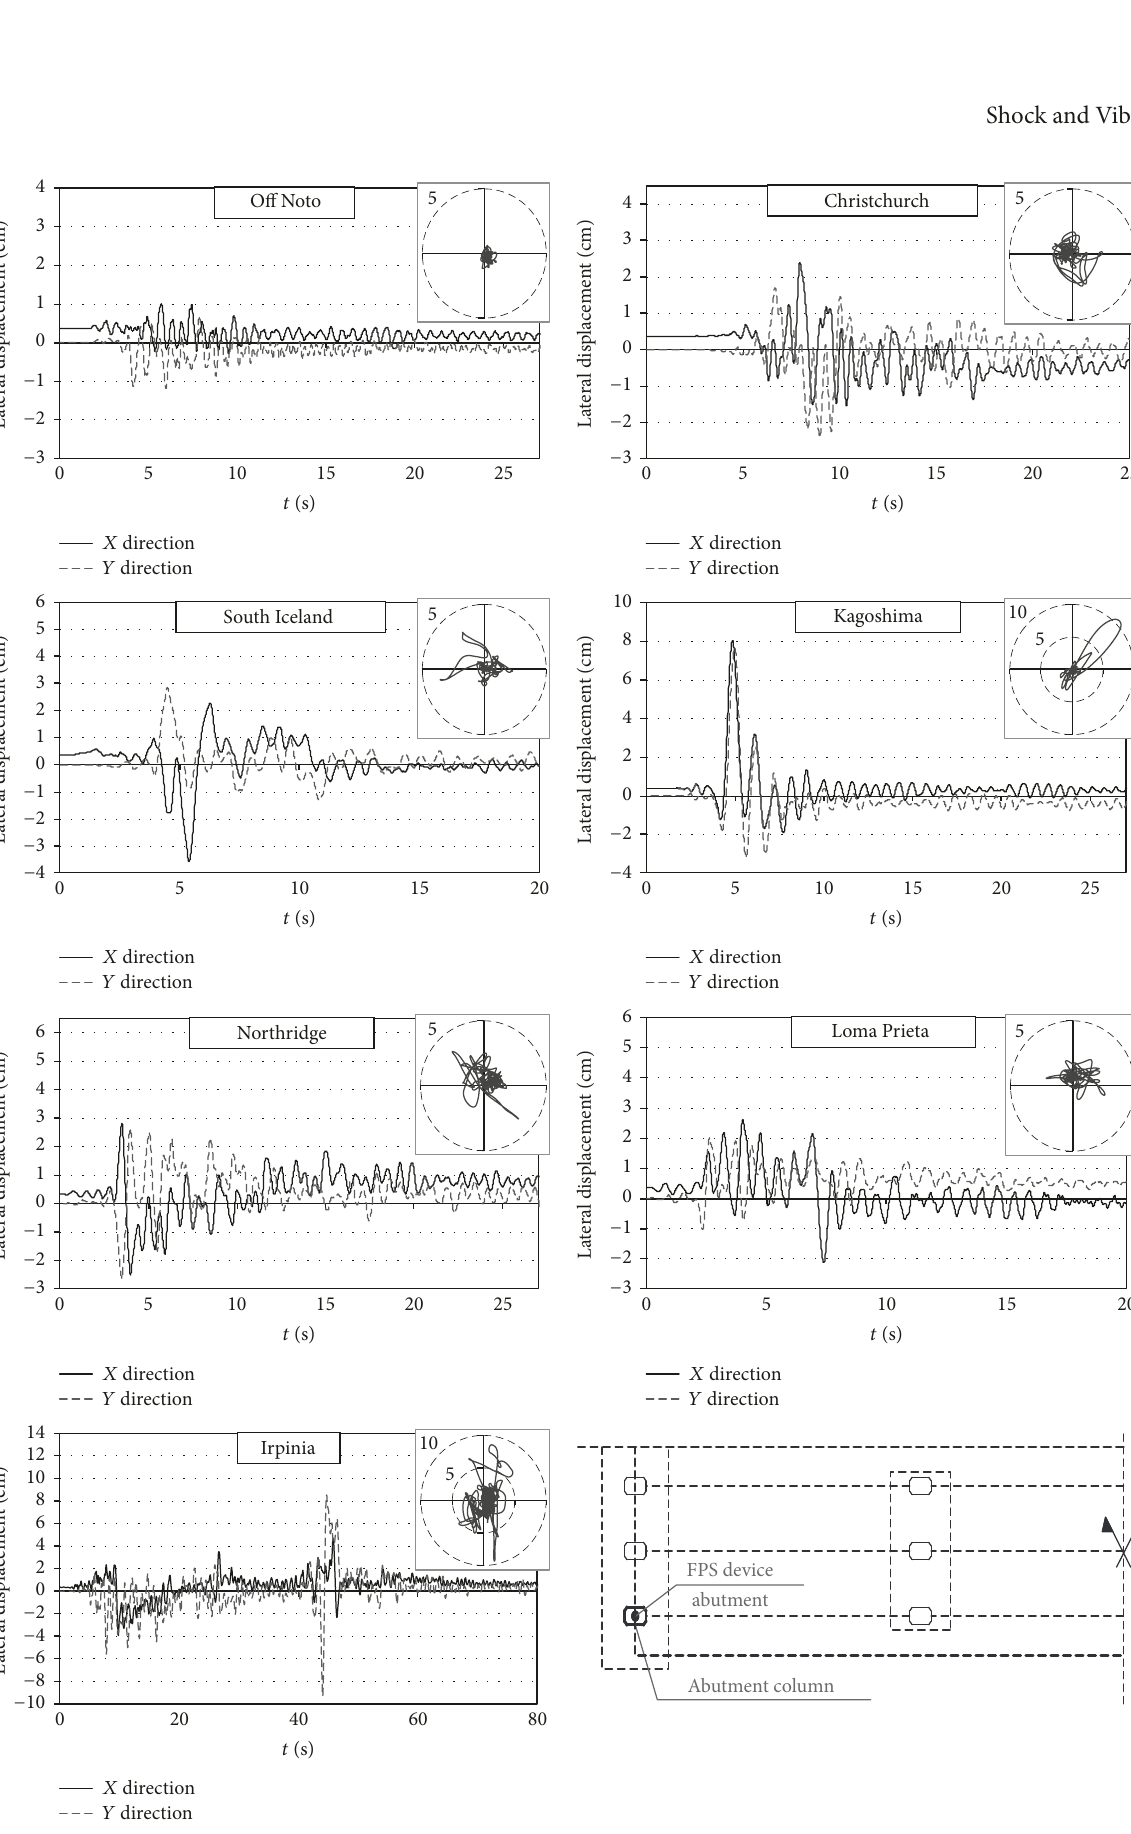
Figure 14: Seismic response of the FPD isolators placed at the top of abutment external column for earthquake along the transverse